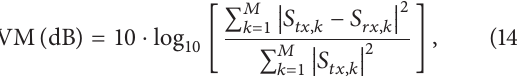
The wireless end-user will receive the three MIMO signals and demodulate them using the suitable QAM demodulation and MIMO decoding